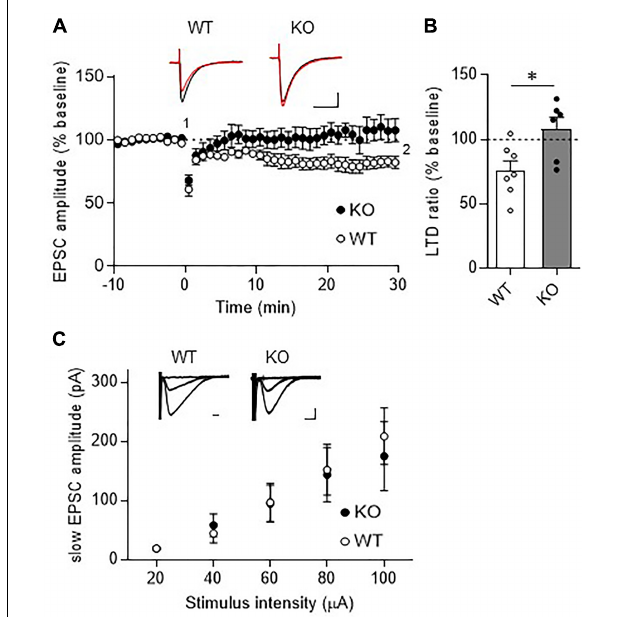
FIGURE 4 | Absence of LTD in TRH-KO mice. (A) Time course depicting PF EPSC amplitudes before and after a conjunctive stimulation (KO: six PCs from four mice, WT: eight PCs from five mice). Representative traces before (1) and 30 min after (2) the conjunctive stimulation is shown as black and red lines. Scale bar: 100 pA, 50 ms. (B) Percent ratios of PF EPSC amplitudes 30 min after a conjunctive stimulation relative to those before the conjunctive stimulation. Asterisks indicate statistically significant differences as determined using Welch’s t -test ( ∗ P < 0.05). (C) Input–output graph showing slow EPSC amplitudes against the intensity of stimulus delivered to PFs. Representative traces of slow EPSCs at 20 µ A, 60 µ A, and 100 µ A stimulus intensity are presented above the graph. Scale bar: 100 pA, 200 ms (WT: eight PCs from four mice, KO: seven PCs from three mice). EPSC, excitatory postsynaptic current; KO, knock-out; LTD, long-term depression; PF, parallel fiber; WT,